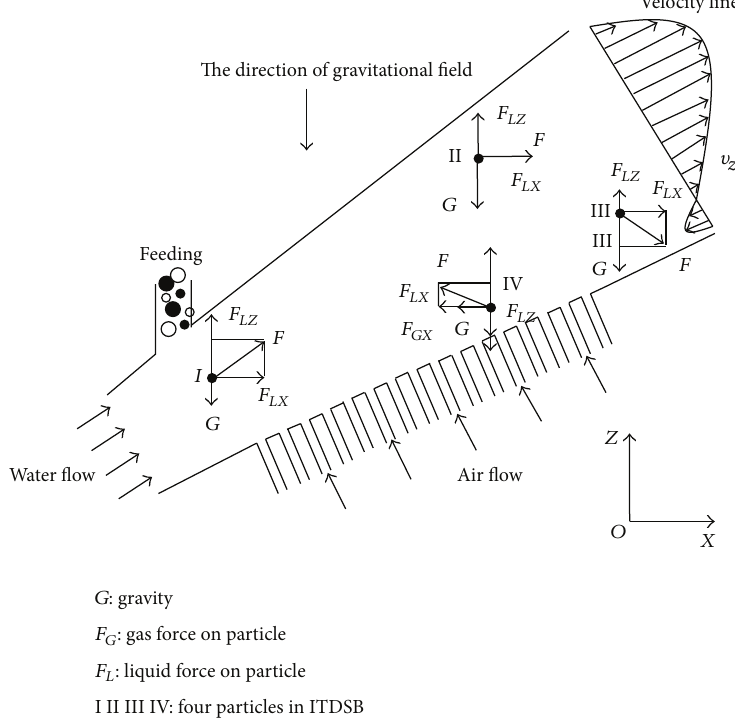
Figure 2: Sketches depicting how changes in diameter and forces impact particles.